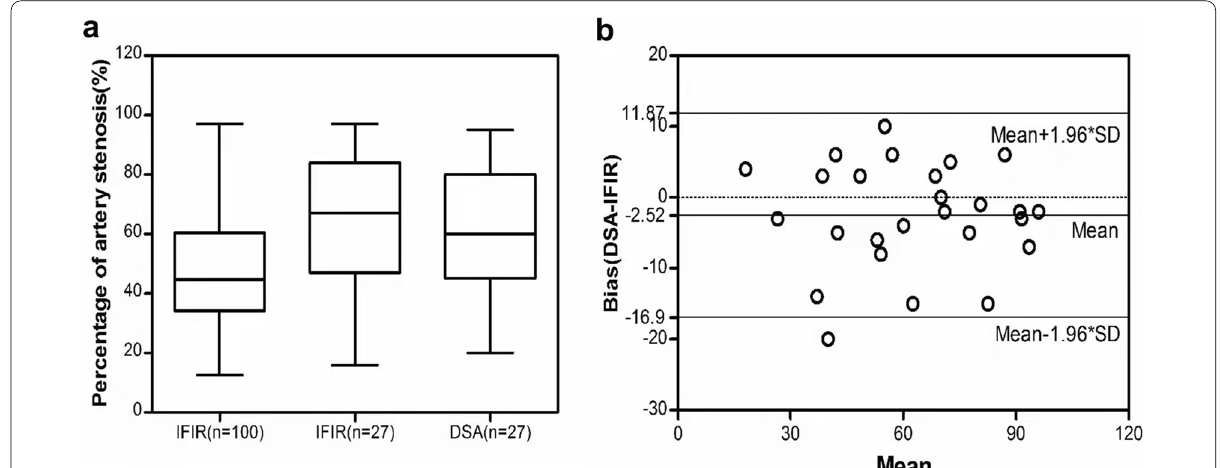
Fig. 2 a Box plot of the percentage of stenosis detected by IFIR in patients with TRAS ( n ( n 27). The x -axis represents groups, and the y -axis represents percentage of stenosis. b A Bland–Altman plot was performed, 95% confidence = interval was 16.90 to 11.87, and there was one sample (3.7%, < 5%) out of the 95% CI, which demonstrated strong consistency between DSA and −